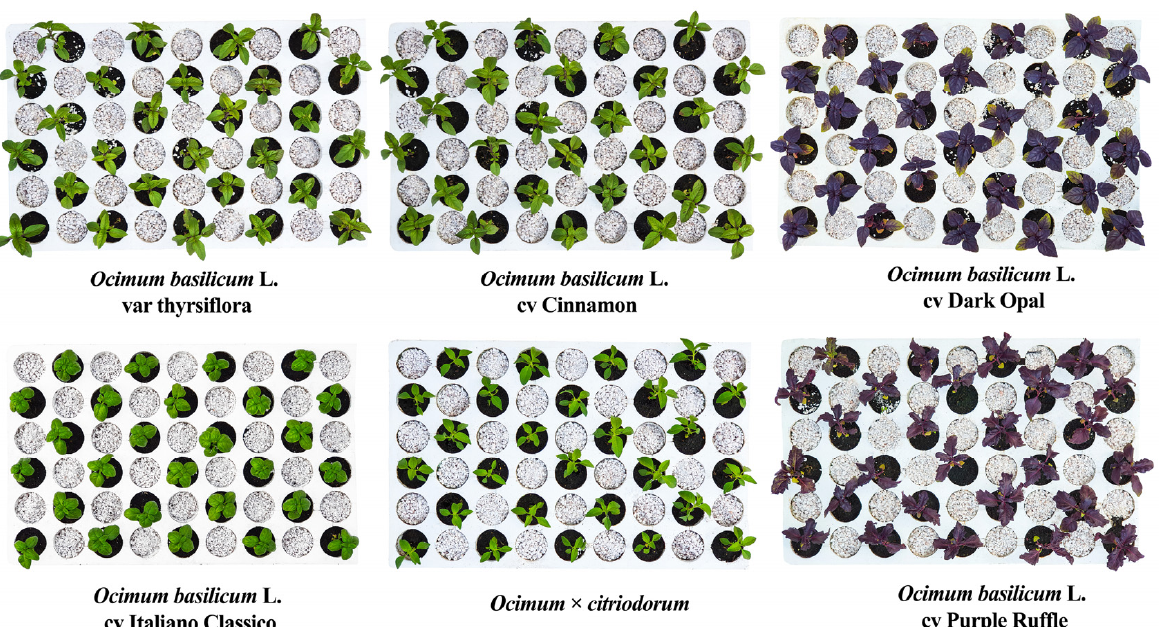
Figure 5. Illustrative picture of basil genotypes used in the experiment.